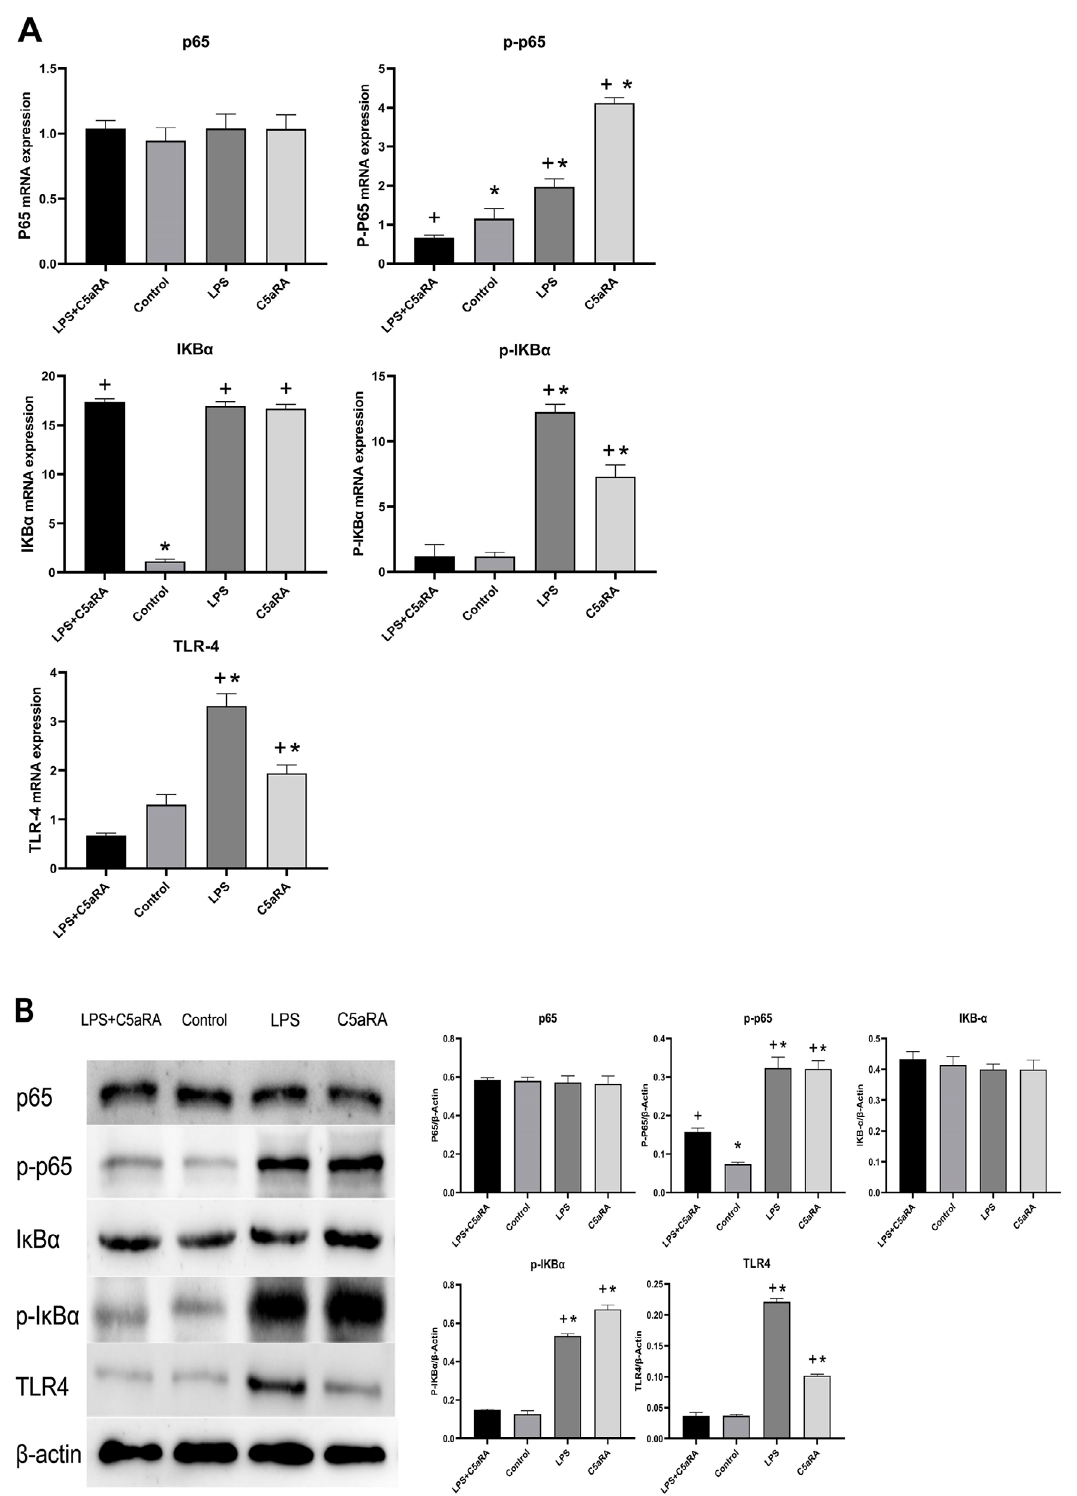
Figure 6- Effects of C5aRA on NF-κB signaling pathway activation and TLR4 expression in LPS-stimulated HGFs.(A) Effects of C5aRA on mRNA levels of p65, p-p65, IκBα, p-IκB α and TLR4 in LPS-stimulated HGFs.(B) Effects of C5aRA on protein levels of p65, p-p65, IκB α , p-IκB α and TLR4 in LPS-stimulated HGFs. Data represent the mean ± SEM of three independent experiments. +P<0.05 vs. the control group. *P<0.05 vs. the LPS+C5aRA